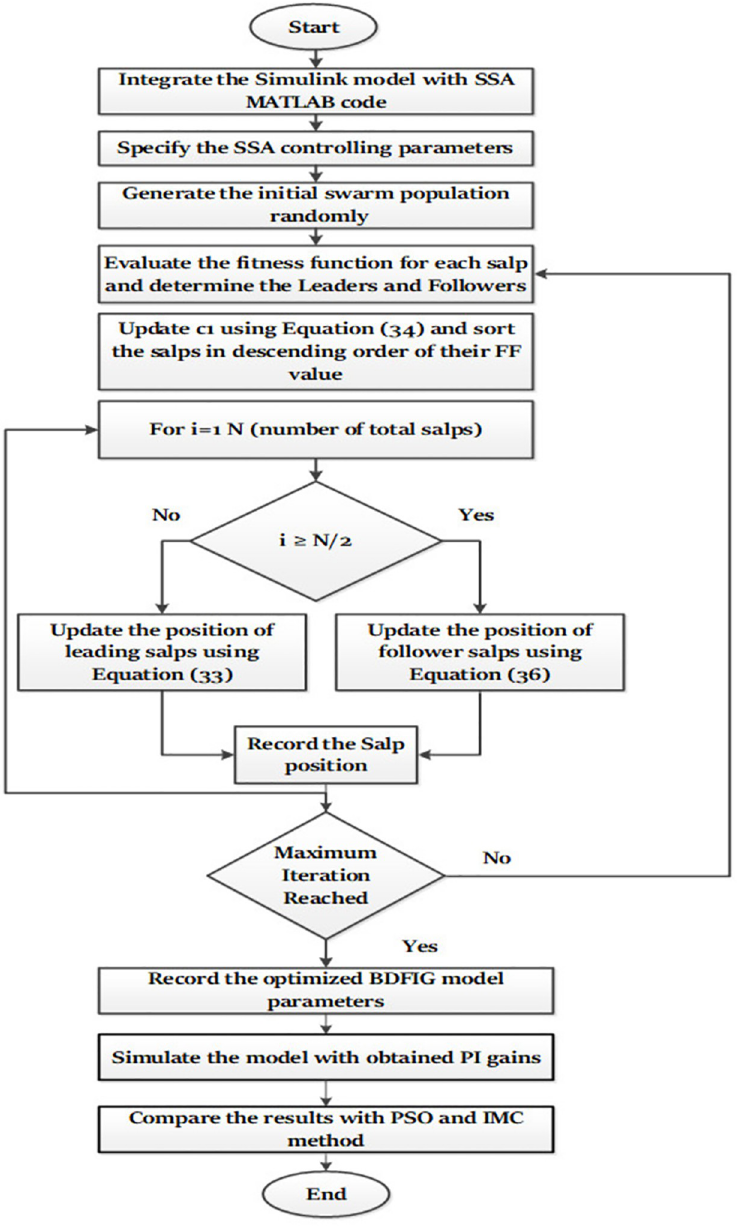
Fig 6. Flowchart of the proposed